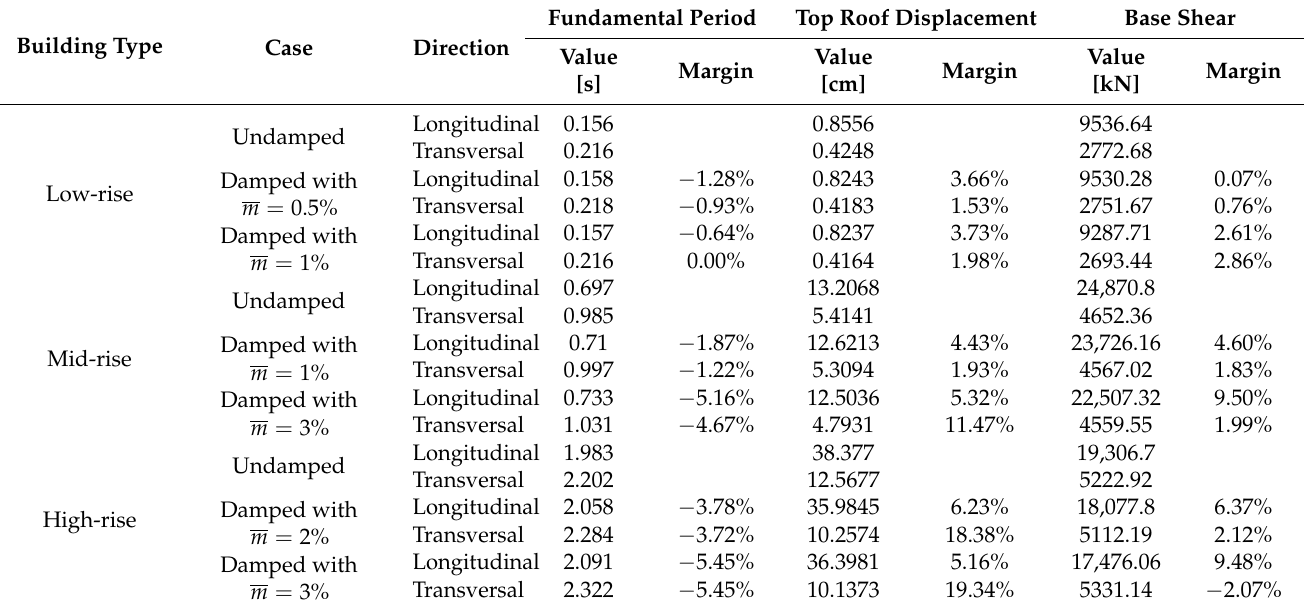
Table 5. Responses of the three investigated buildings for the two different mass ratio of TMD with margin from undamped case.